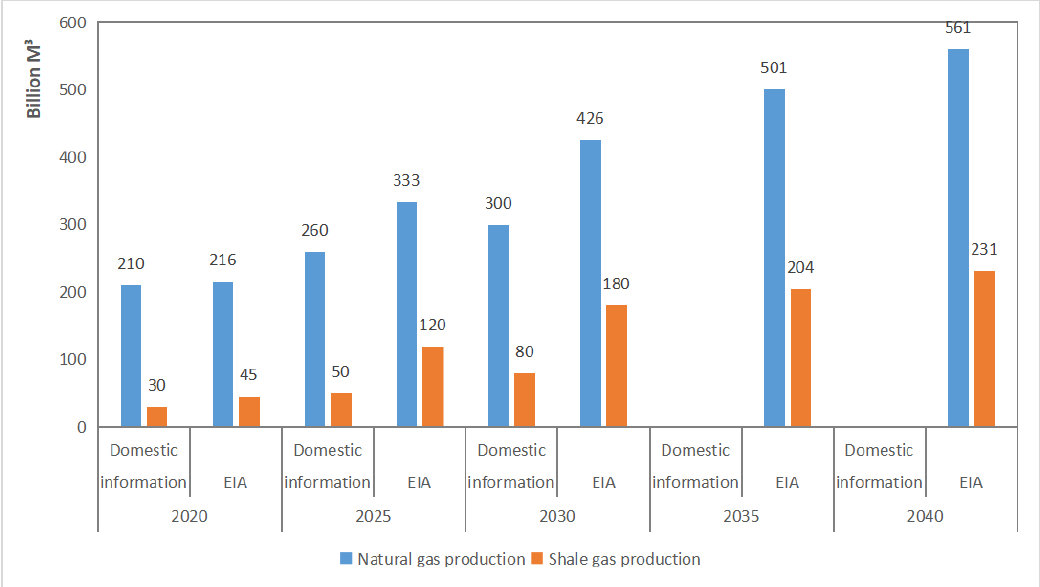
Figure 3. China’s future production of conventional natural gas and shale gas.